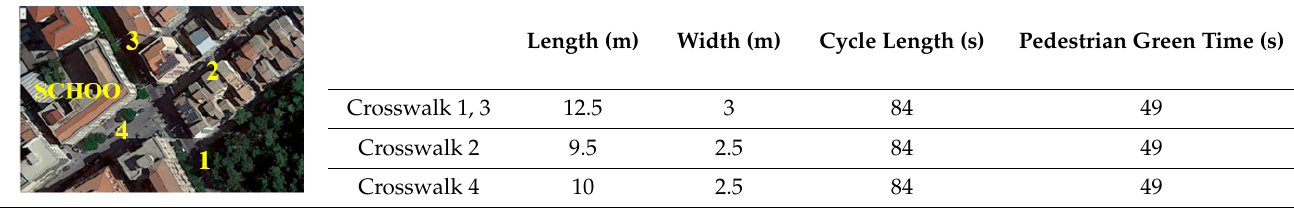
Table 1. Basic characteristics of crosswalks in Enna, Italy.